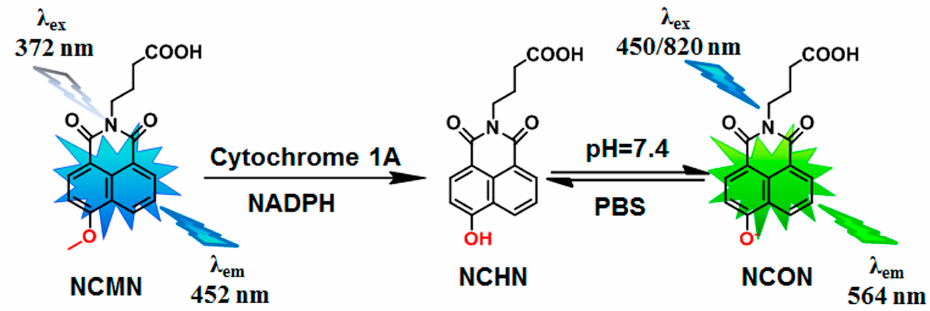
Figure 1. The chemical structure of N -(3-carboxy propyl)-4-methoxy-1,8-naphthalimide (NCMN) and its fluorescence response towards mammalian cytochromes 1A from different species.